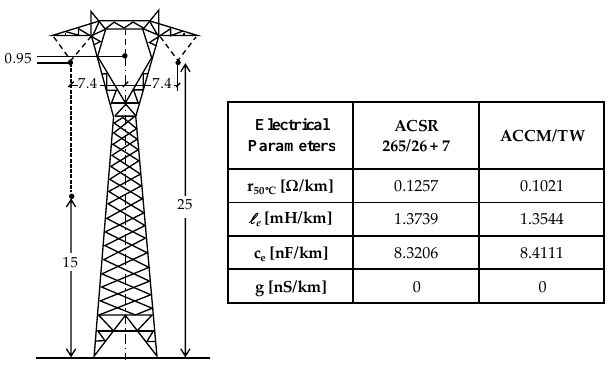
Figure 10. HV OHL case study: tower layout and per unit length electrical parameters.